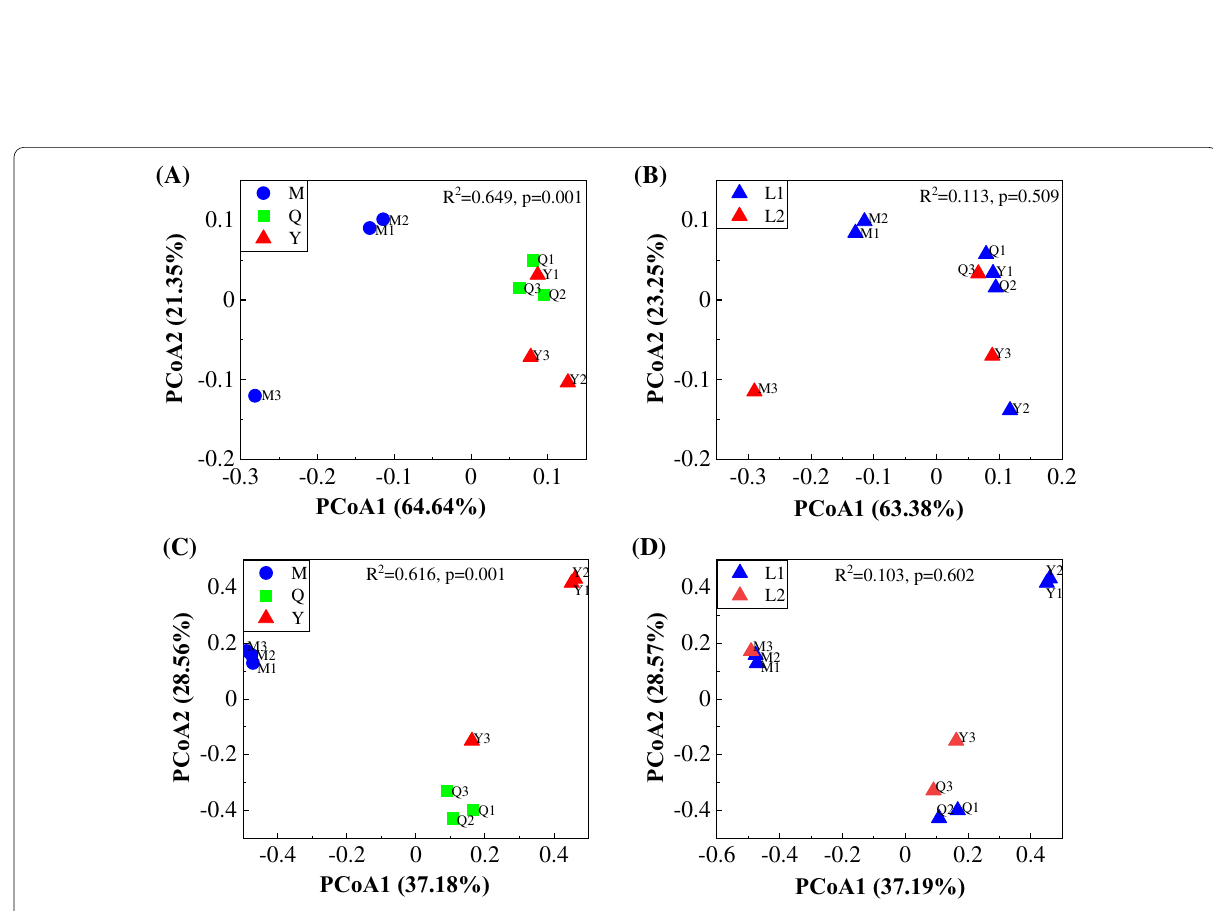
Fig. 3 Principal coordinate analysis (PCoA) of weighted UniFrac distances of the bacterial ( A / B ) and fungal ( C / D ) community under different microflora sources ( A / C ) and liquid volumes ( B / D ). M, microbial consortia source from MC1; Q, microbial consortia source from MC1, sheep, and cattle feces; Y, microbial consortia source from sheep feces; L1, 100 mL PCS medium; L2, 200 mL PCS